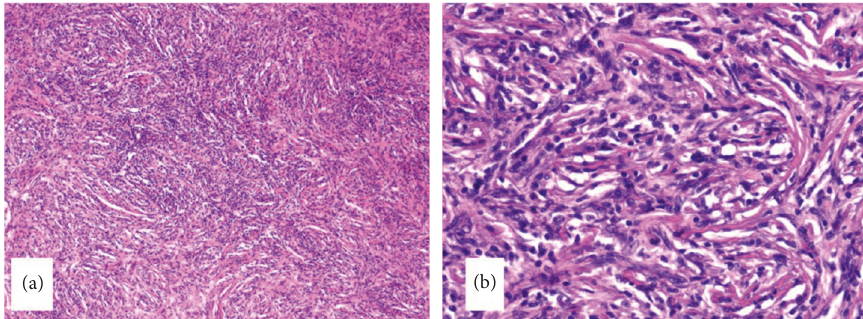
Figure 2: The tumor was composed of spindle cells and inflammatory cells. The spindle cells were arranged in bundles or spirals. HE100 × (a); HE400 × 3 breast solid lesion. The surgeon considered fibroadenoma. Lumpectomy was performed in December 2019 and was submitted for pathology examination.